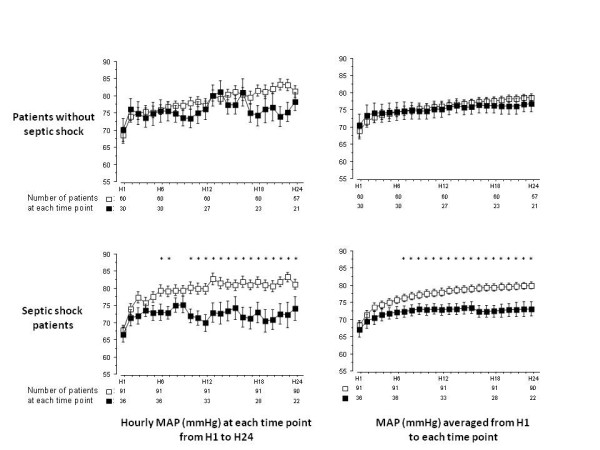
Mean arterial pressure (MAP) according to the presence or not of septic shock. The MAP (from H6 to H24 for hourly MAP and for time-averaged MAP) was significantly lower in patients who will than in those who will not have AKI at H72 in the septic shock population (as indicated by an asterisk upon each time point) (bottom panels), while no difference was found in the non septic shock patients (top panels). Asterisks upon time points indicate a significant difference (P < 0.05) between patients who will have AKI at H72 (black squares) and those who will not (open squares) (post hoc comparison after analysis of variance). Error bars represent standard errors.